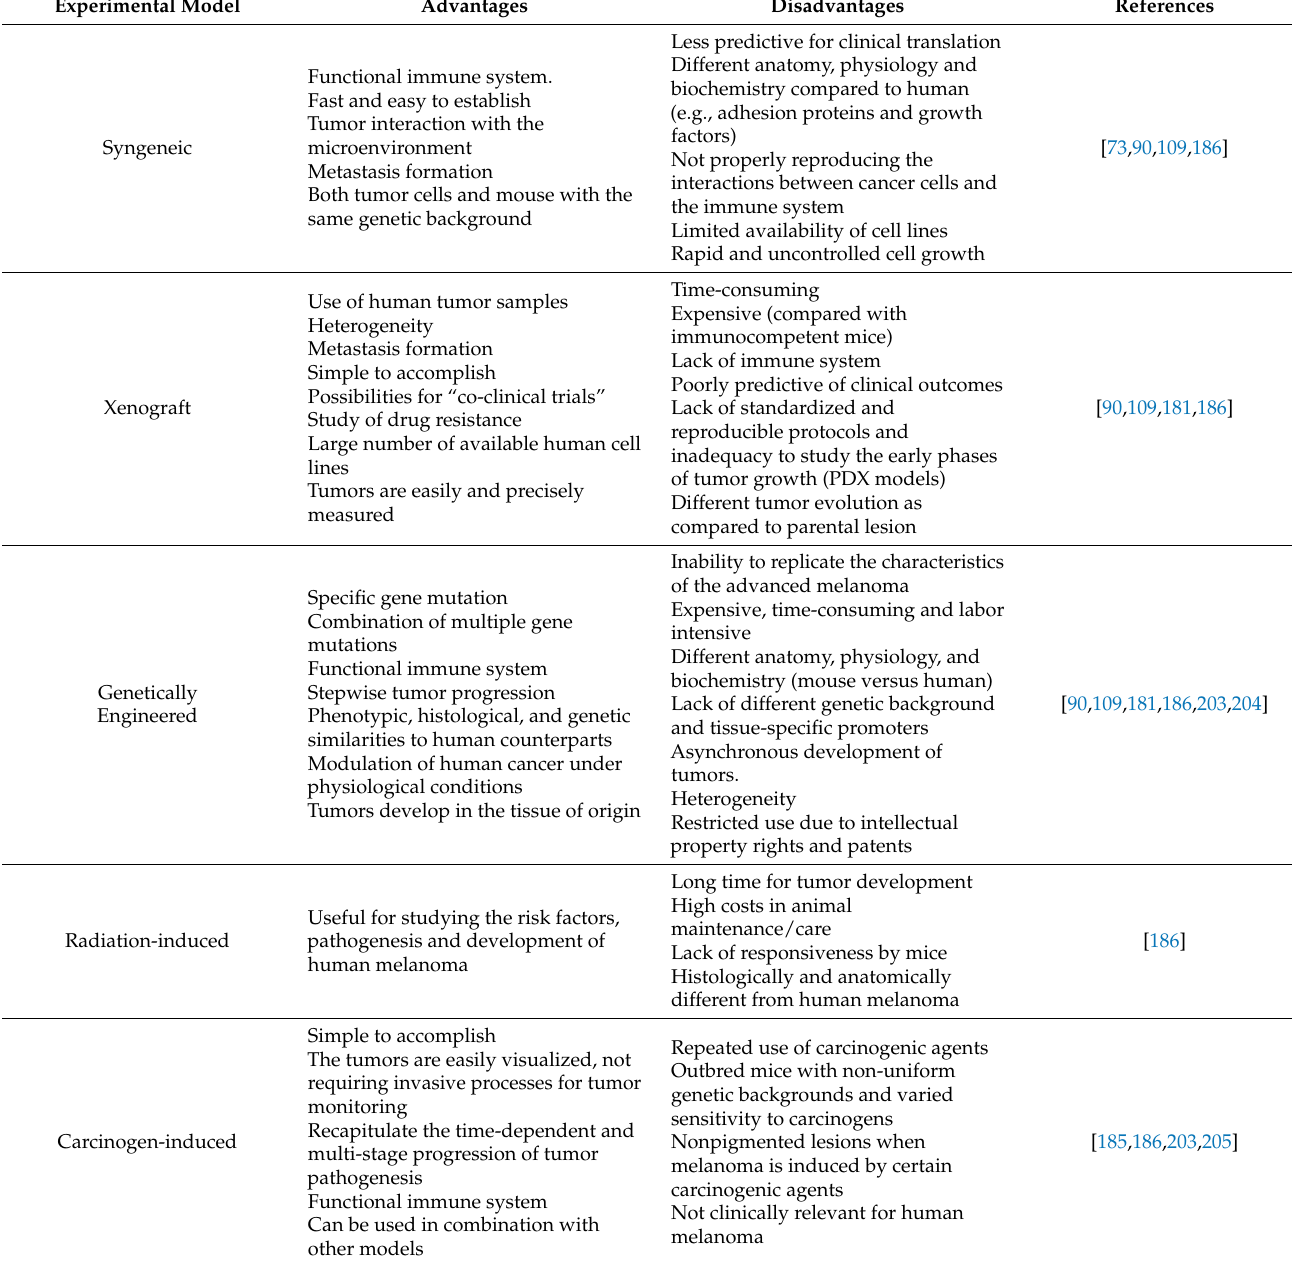
Table 3. Main melanoma murine models: advantages and